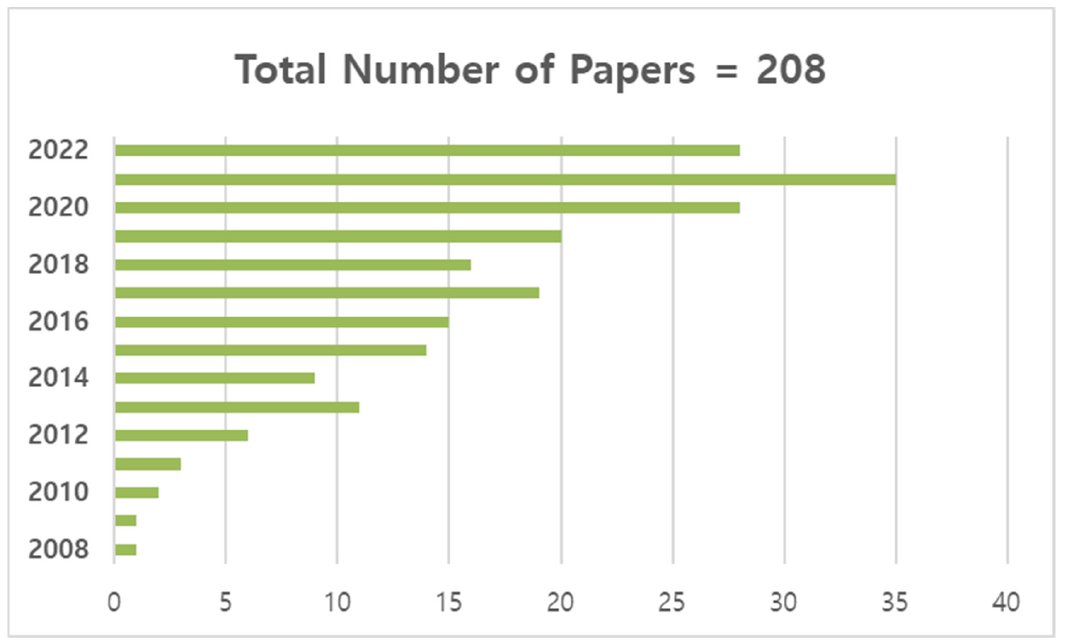
Figure 1. Arithmetic conceptualization of GWL research using AI-based model during 2008–2022.